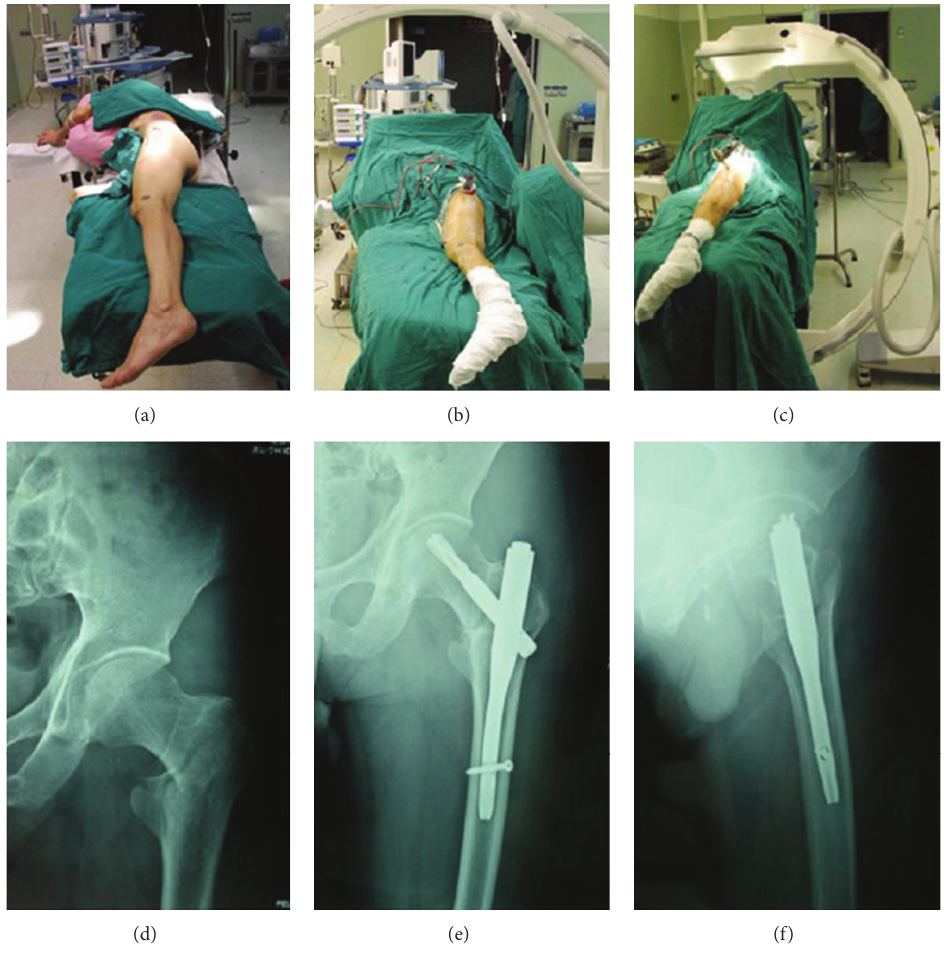
Figure 1: Surgical procedures in the lateral decubitus position. (a) Before treatment, these patients maintained lateral decubitus position, and the disinfection soft pillow was set between the legs, and the healthy limb maintained flexion of their hip and knee. (b) X films are obtained from anterior and posterior positions of hip. (c) C-arm in the “over the top” position to obtain the lateral X films of the hip and maintain approximately 60 ∘ with the horizontal plane. (d) Before treatment, X film in intertrochanteric fractures (left side; AO type, 1A1.2); (e) and (f) After treatment, the lateral and anteroposterior X films of the hip are showed,